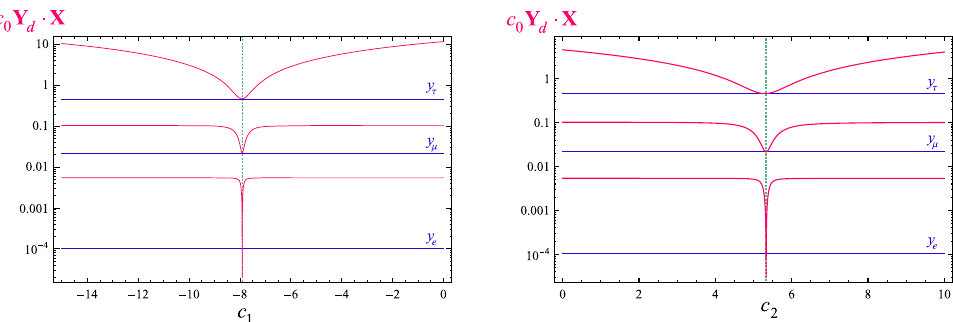
Figure 1 . Evolution of the singular values of Y e = c 0 Y d (cid:1) X , with X (cid:17) 1 + c 1 Y y as a function of the coe(cid:14)cient c 1 or c 2 , holding the other parameters (cid:12)xed. This evolution is very smooth, except for the dip occurring when c 1 or c 2 is such that det X = 0. The green dashed lines indicate the point at which the singular values of Y e coincide with the observed lepton Yukawa couplings, which clearly sits deep inside the dip (these values correspond to the MSSM at the GUT scale and tan (cid:12) = 50, see eq.